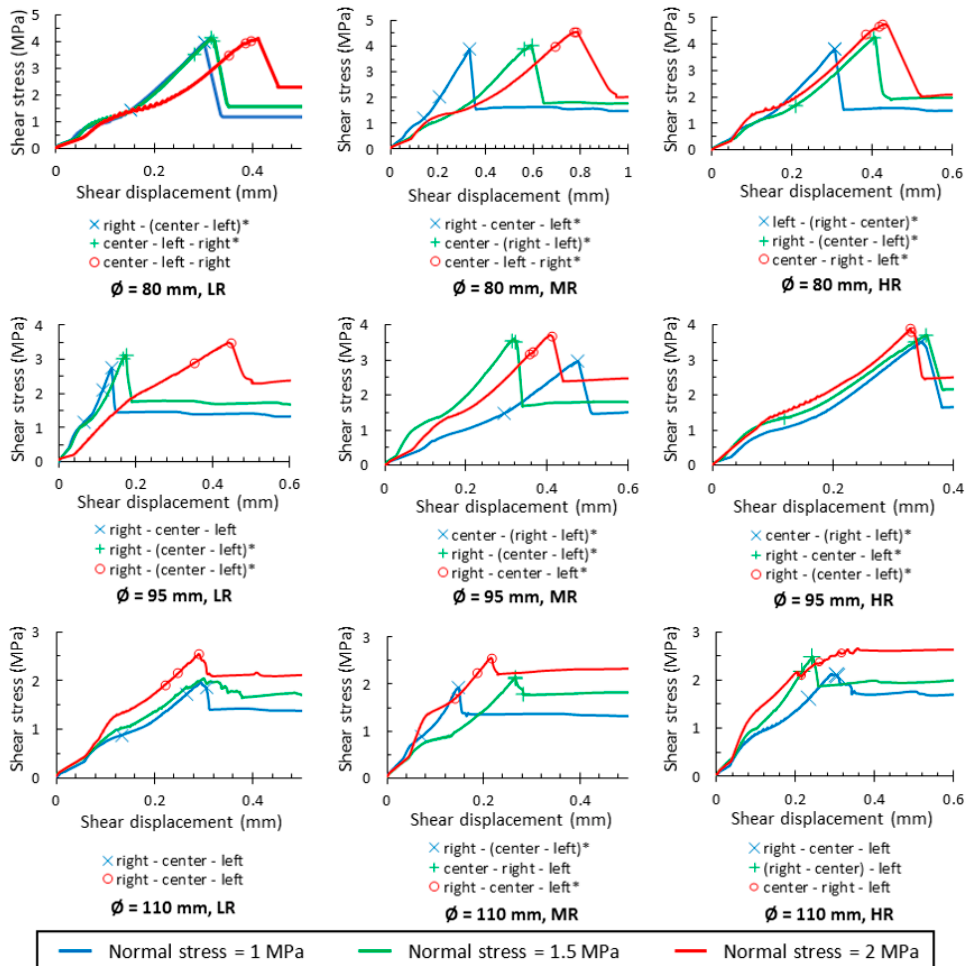
Figure 17. Crack initiation moments and the sequence of the cracks that lead to the failure of J&Br specimens containing a single joint with different sizes (Ø = 80 mm, Ø = 95 mm, Ø = 110 mm) and roughness (LR, MR, and HR) subjected to different normal stresses (1 MPa, 1.5 MPa, and 2 MPa).